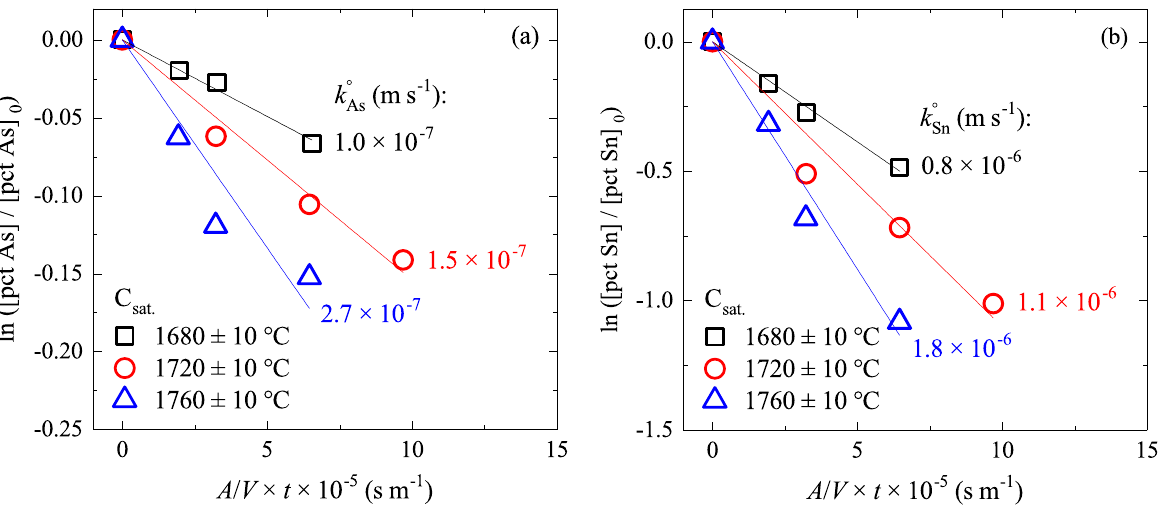
Figure 3. Changes of ( a ) [pct As]/[pct As] 0 and ( b ) [pct Sn]/[pct Sn] 0 in C-saturated Fe–C–As–Sn alloys at various temperatures. (color online)